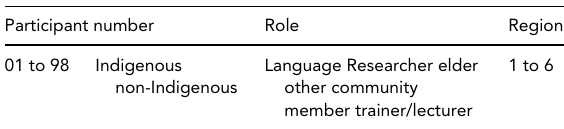
Codes Used to Refer to Research Participants. The Characters in Bold are Those Used to Refer to that Identifying Feature of the Participant. Participants are Not Identified to Maintain